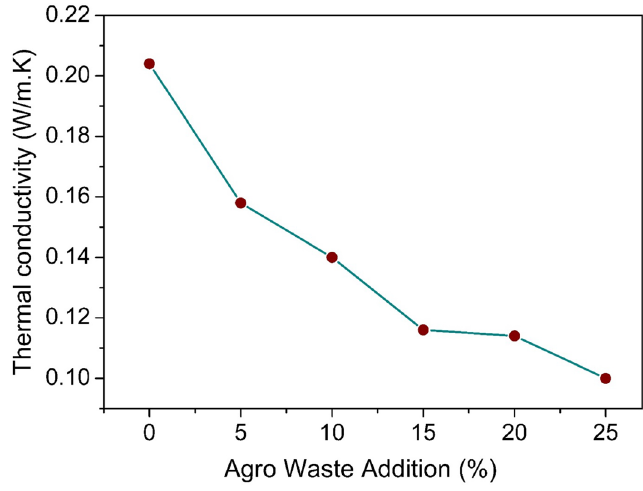
Figure 6. Thermal conductivity variation of rice straw added gypsum